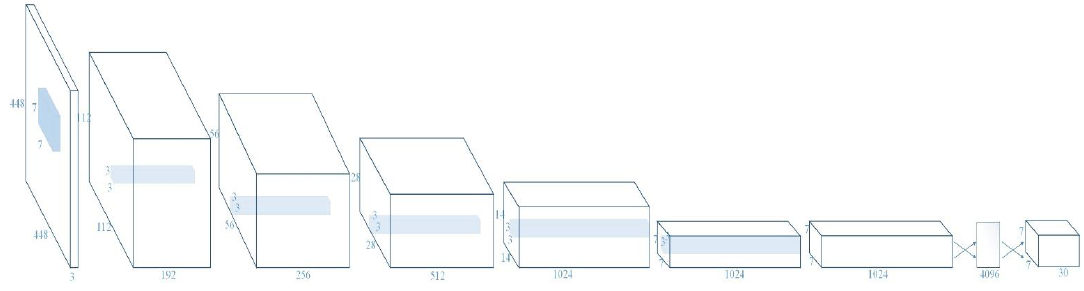
Figure 4. Darknet